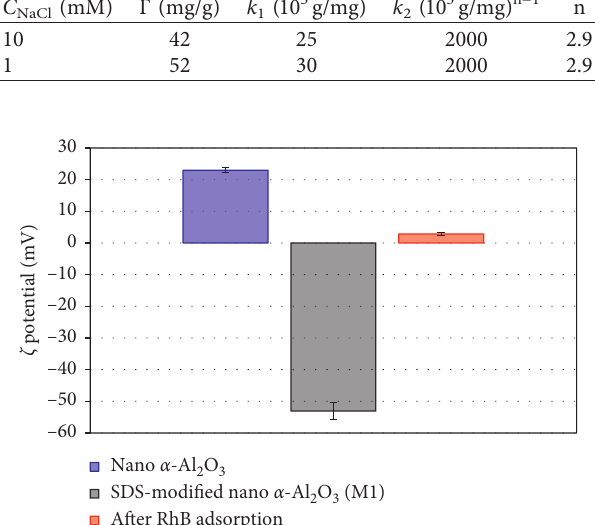
Figure 6: The ζ potential of synthesized nano α -Al modified nano α -Al 2 O 3 ( M 1), and M 1 after RhB adsorption in 10mM NaCl (pH 5).